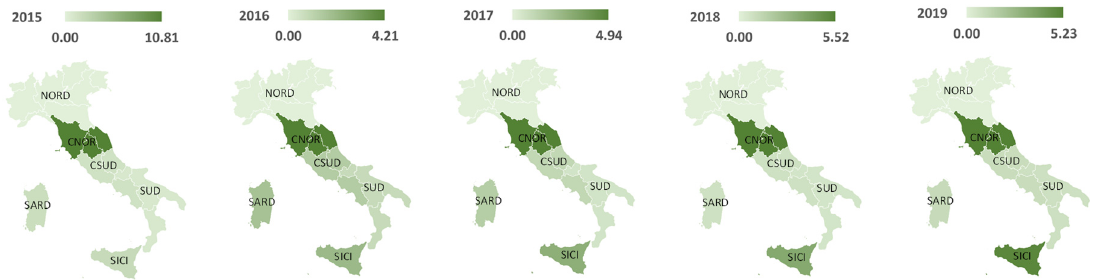
Figure 8. A 100 MW increase in wind generation in each zone; impact on electricity price in the same zone ( €/MWh ); 2015 – 2019.